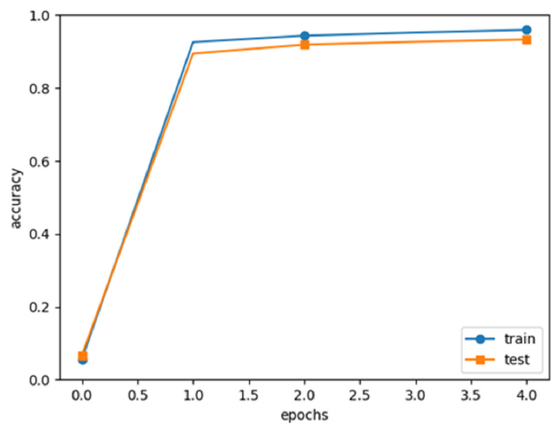
Figure 11. Result of native Python model training and testing.